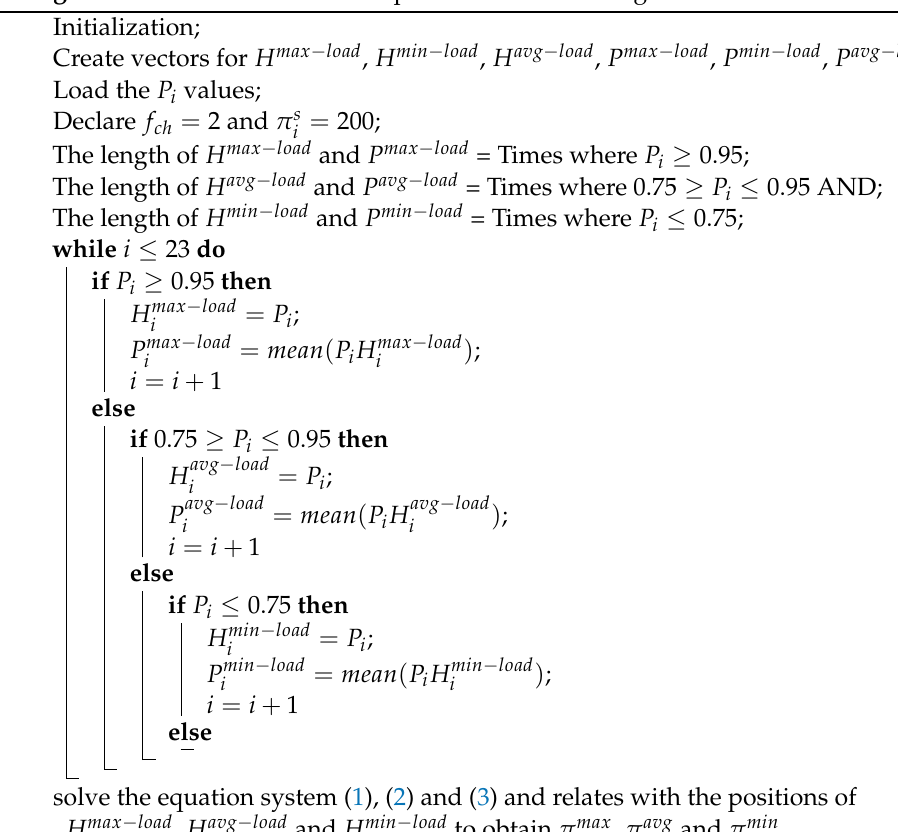
Algorithm A1: Executed for Compute Threshold Pricing